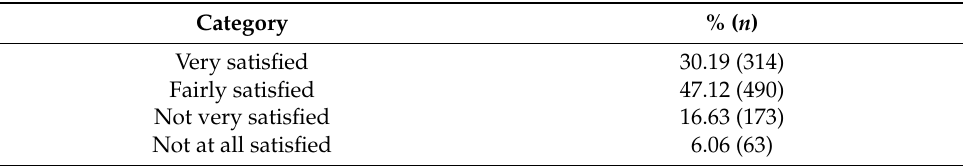
Table 2. Satisfaction with restriction